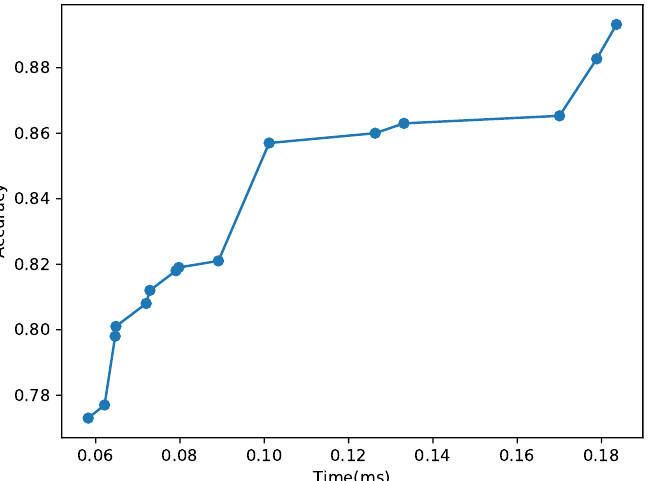
Figure 15. Pareto Optimal CNNs for CIFAR-10. This figure also shows that several Pareto opti- mal CNNs have similar inference times and accuracy, further emphasizing the need to build H δ P consisting of δ -Pareto CNNs